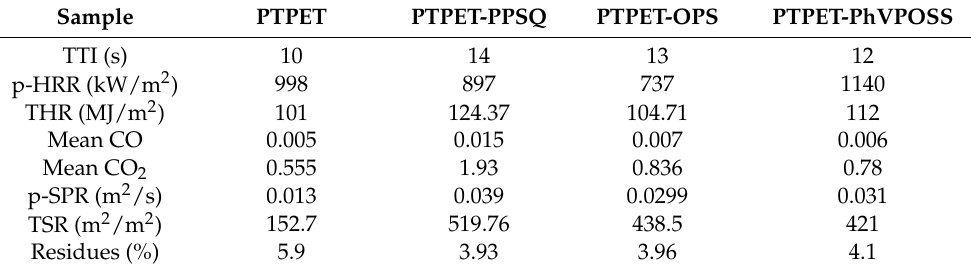
Table 5. Cone test data of PTPET elastomer and composites.